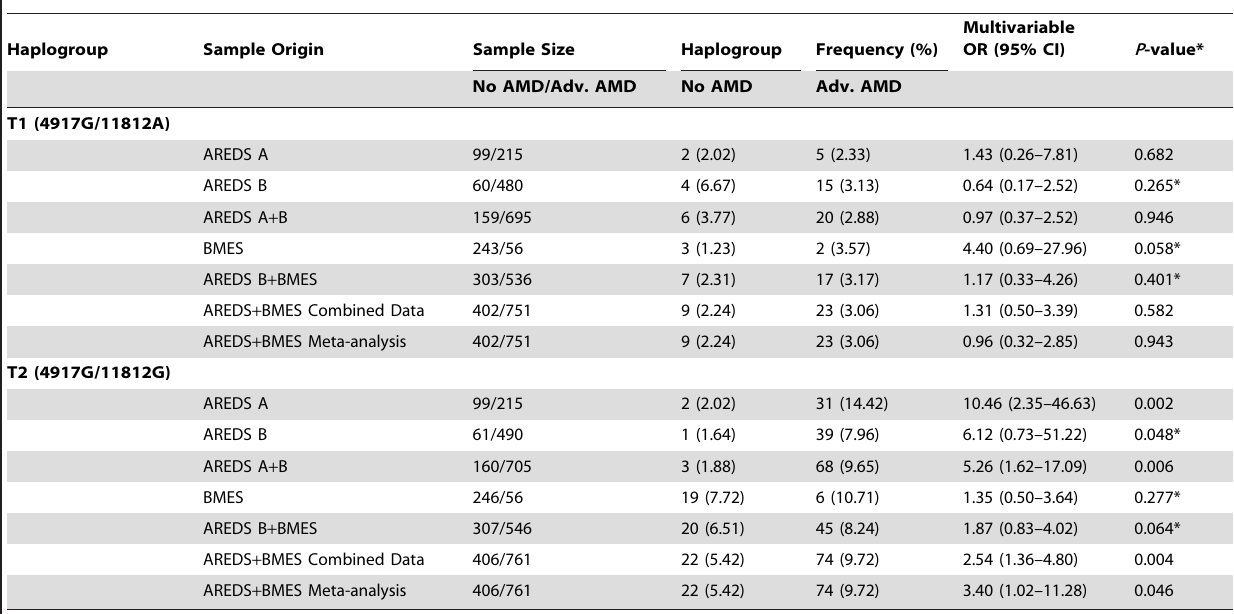
Table 2. Measures of association for advanced AMD with variants characterizing T haplogroups.